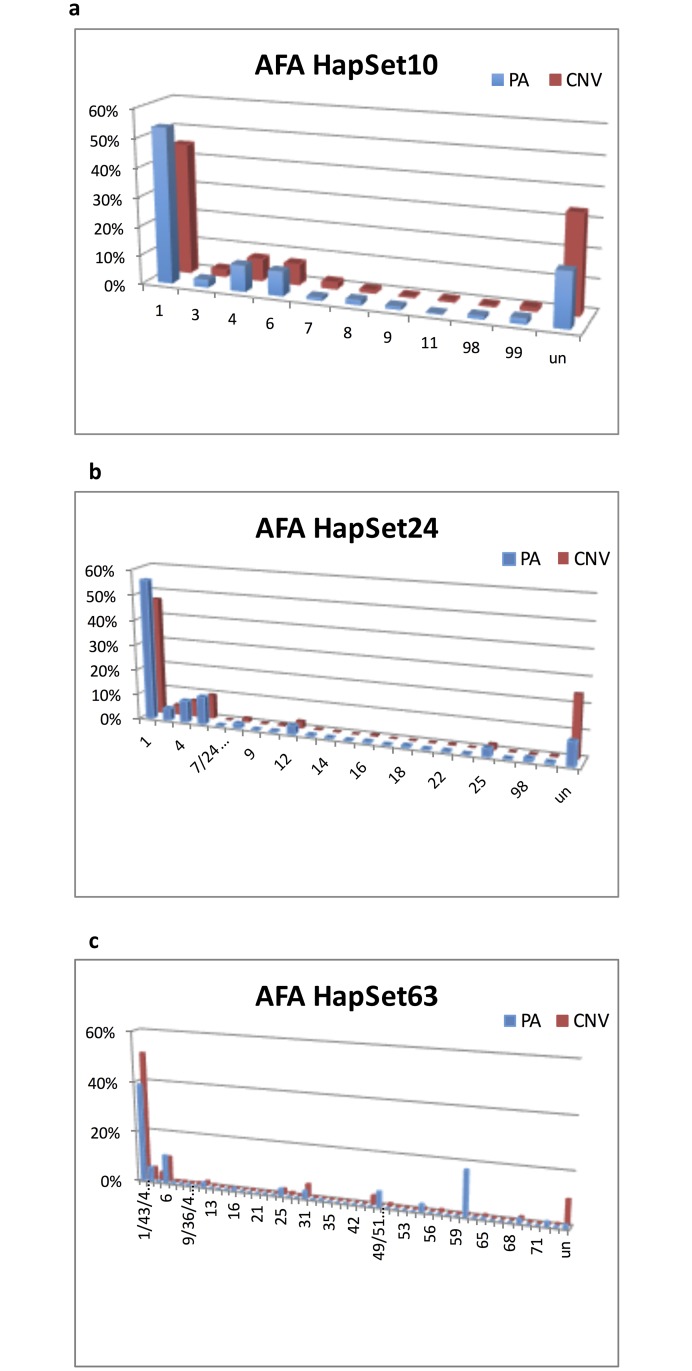
Estimated PA + CNV haplotype frequencies for AFA.Frequencies are plotted by typing resolution and reference haplotype set. Haplotypes are on the x-axis, frequencies on the y, and populations on the z. Each PA haplotype may be equivalent to multiple CNV haplotypes; for example, CNV haplotypes 7 and 24 are equivalent at PA resolution.